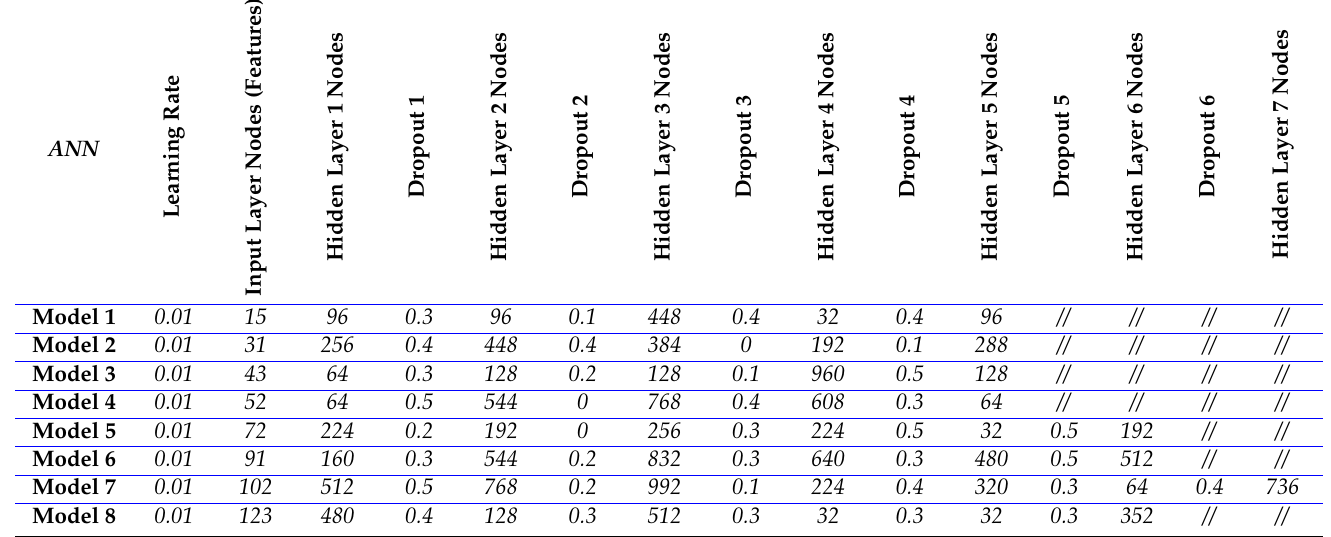
Table A1. Optimal hyperparameters for the ANN models (d-serie laser